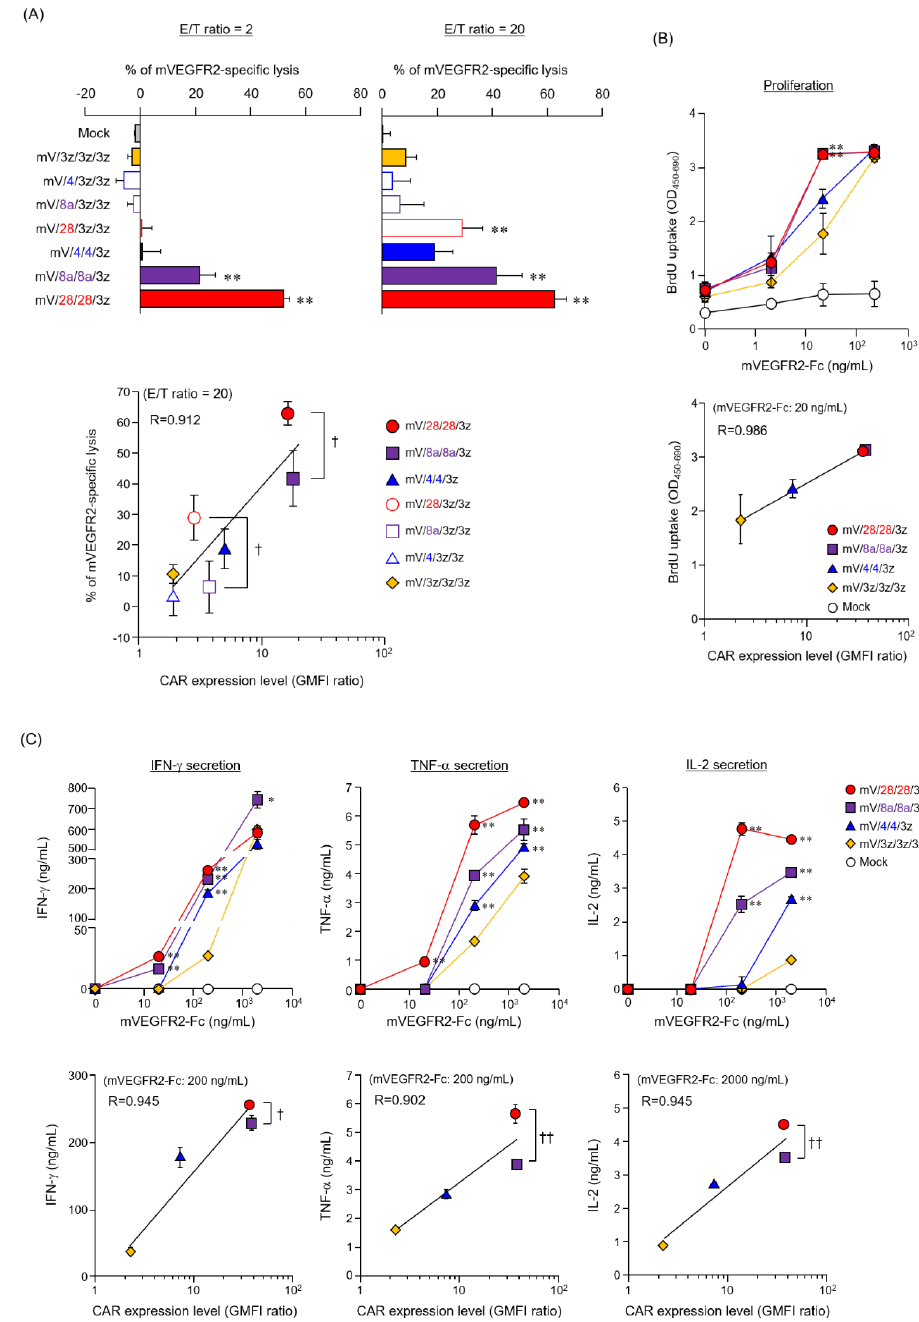
Figure 3. Functional characteristics of mouse T cells expressing CARs with different hinge domain (HD) and transmembrane domain (TMD). ( A ) Top panel, cytotoxic activity of HD-modified and HD / TMD-modified CAR-T cells four days after Rv transduction against mVEGFR2 + EL4 cells; lower panel, relationship between cytotoxicity at E / T ratio = 20 and CAR expression level. ( B ) Top panel, proliferation activity of HD / TMD-modified CAR-T cells following mVEGFR2-stimulation; lower panel, relationship between proliferation activity upon stimulation with mVEGFR2-Fc 20 ng / mL and CAR expression level. ( C ) Top panel, cytokine-producing ability of the above cells: interferon- γ , tumor necrosis factor- α , and interleukin-2; lower panel, relationship between cytokine-producing ability upon stimulation with mVEGFR2-Fc 200 or 2000 ng / mL and CAR expression level. The data are representative of at least two independent tests. Statistical analysis was performed using Dunnett’s test against mV / 3z / 3z / 3z; * p < 0.05, ** p < 0.01; or Student’s t -test; † p < 0.05, †† p <